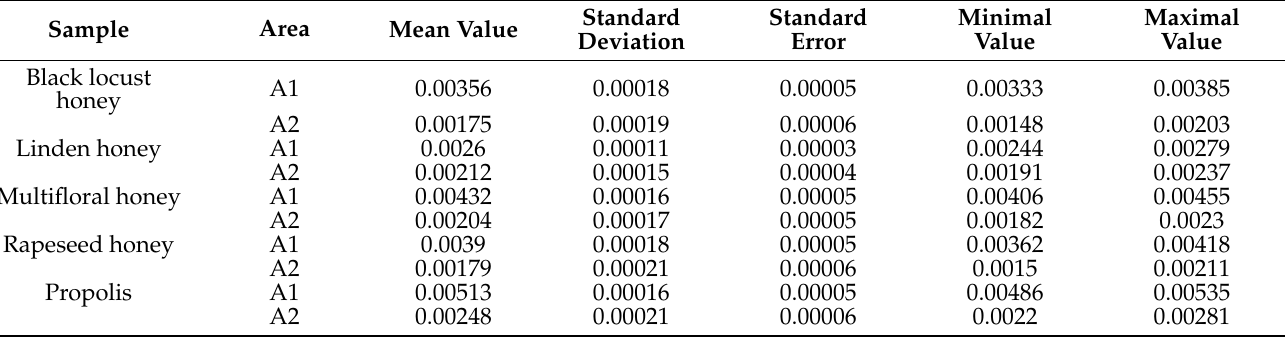
Table 12. Bioconcentration factor for